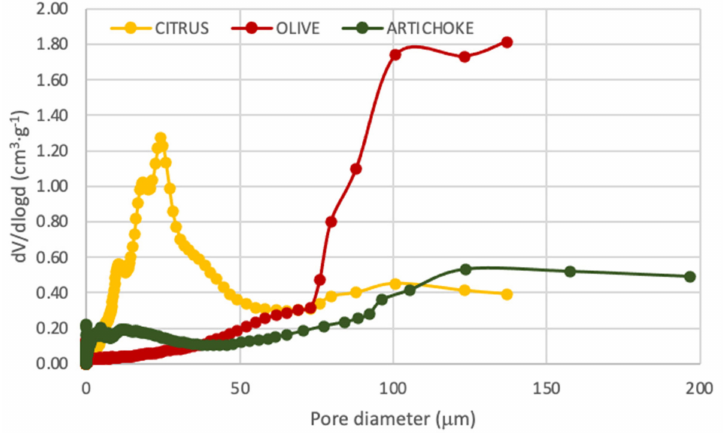
Figure 7. Pore size distribution of macropores in the selected agrifood wastes, performed with Hg